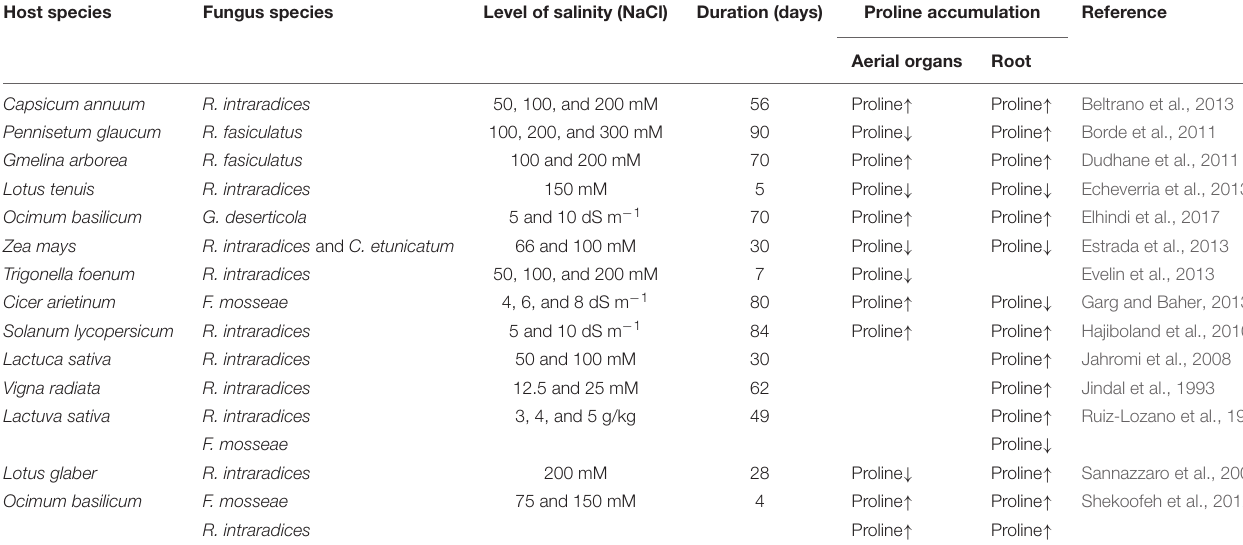
TABLE 1 | Level of proline accumulation influenced by salt stress in Arbuscular Mycorrhizal symbiotic